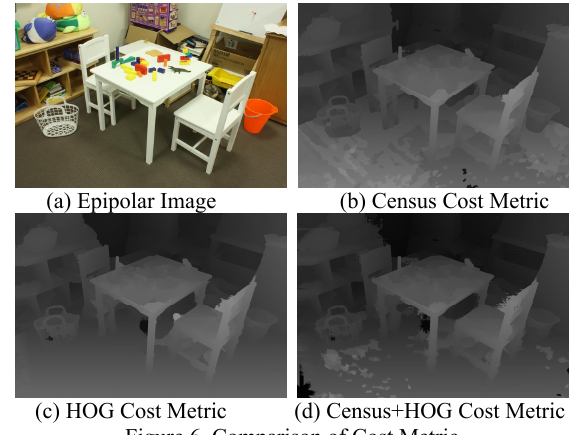
Figure 6. Comparison of Cost Metric